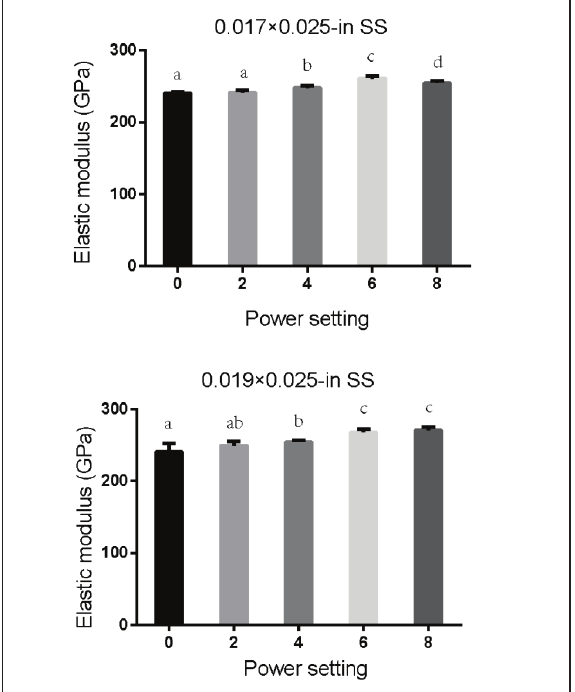
Figure 4. (A) Flexural moduli of the unheated 0.017 × 0.025 inch SS wire specimens and specimens heated at power settings of 2, 4, 6, and 8 for eight seconds. (B) Flexural moduli of the unheated 0.019 × 0.025 inch SS wire specimens and specimens heated at power settings of 2, 4, 6, and 8 for eight seconds. Bars with dissimilar letters indicate significantly different values ( p < 0.05). Each value is presented as the mean ± SD (N =